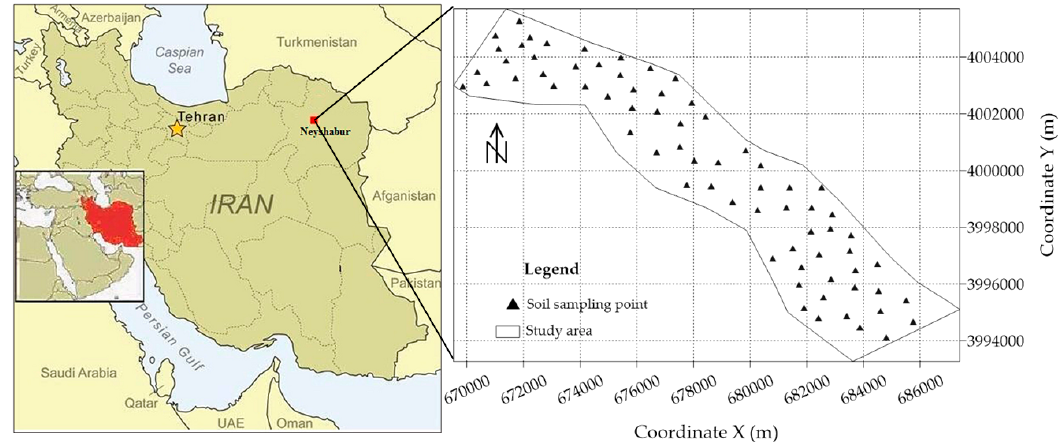
Figure 1. Study area and sampling points.